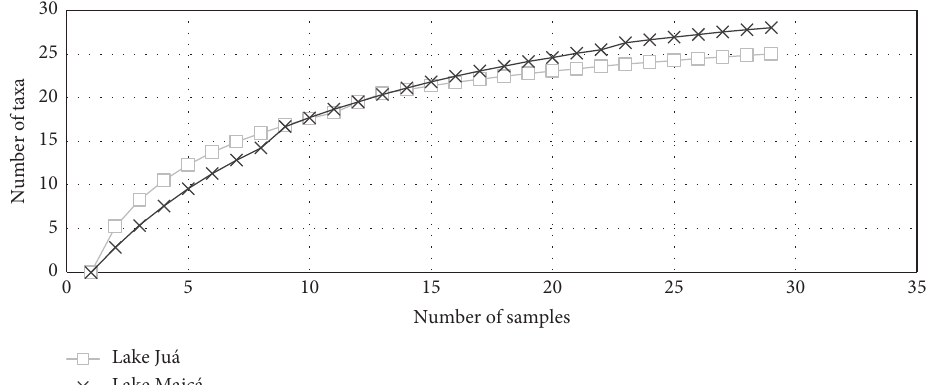
Figure 3: Accumulation curve of the number of fungi taxa found in relation to the sampling effort of collecting submerged fragments of decomposed wood in the Lakes Ju´a and Maic´a, Santar´em, Par´a, Brazil. Table 3: Frequency of taxa observed in samples of submerged wood collected in the Lakes Ju´a and Maic´a, Santar´em, Par´a, Brazil. Taxa